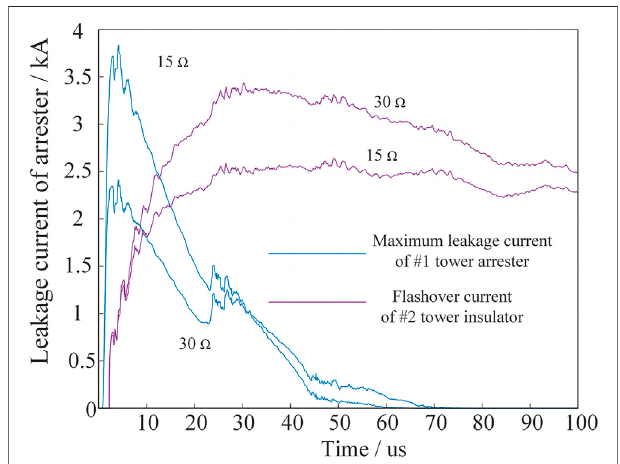
FIGURE 12 | Waveform of maximum leakage current of #1 pole arrester and #2 pole insulator fl ashover current of different tower grounding resistance under 30 kA lightning current amplitude